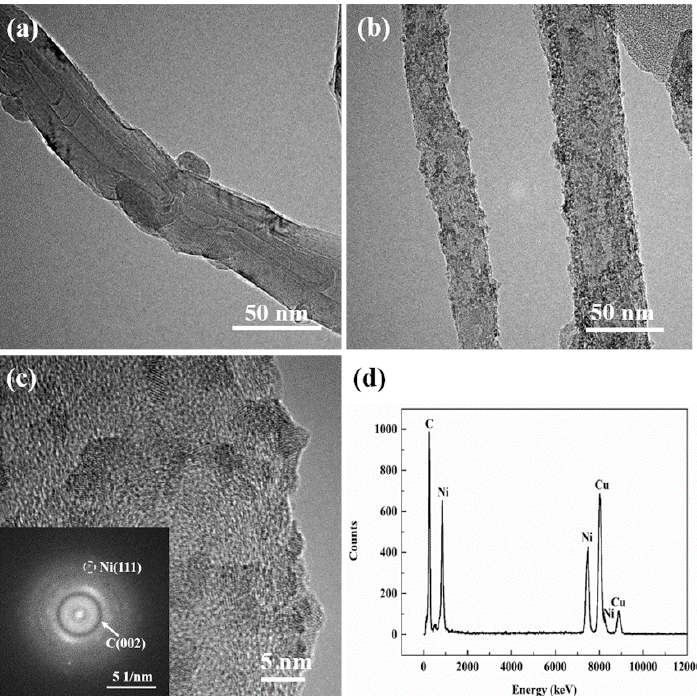
Figure 2. ( a ) TEM observation of raw CNTs; ( b , c ) TEM observation of Ni nanoparticles decorated CNTs; ( d ) EDX spectrum of Ni-CNTs.